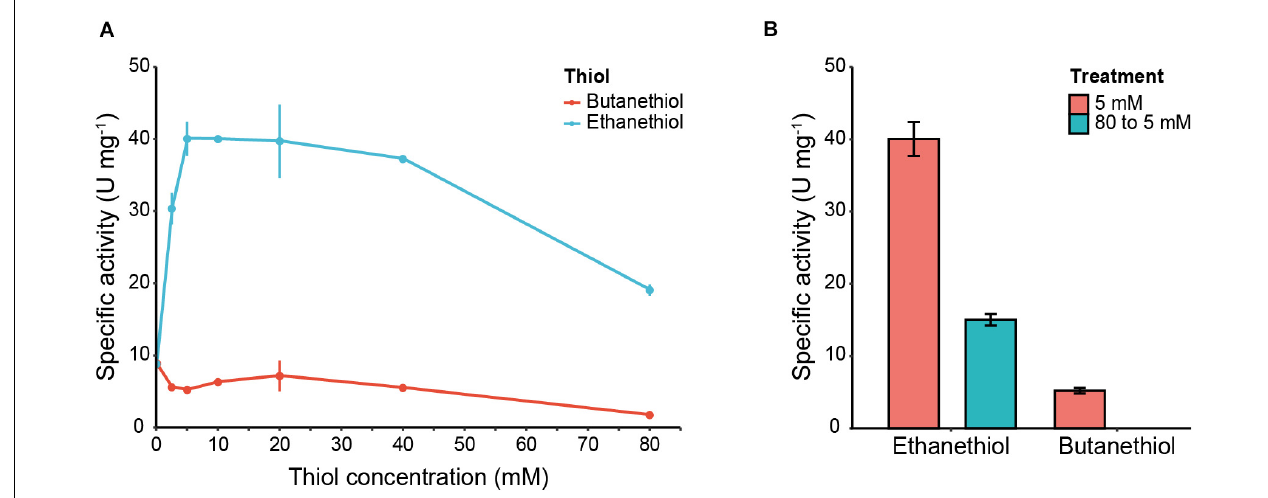
FIGURE 6 | 4-nitrophenol release assay and Eat1 inhibition in the presence of thiols. (A) Effect of 4-nitrophenol release from 4-nitrophenyl acetate incubated with various concentrations (0–80 mM) of ethanethiol or butanethiol. (B) Inhibition assay of Eat1 by exposing Eat1 to 80 mM ethanethiol or butanethiol followed by immediate dilution to a final concentration of 5 mM. Error bars indicate the standard deviation. 1 U = 1 µ mol min - 1 .